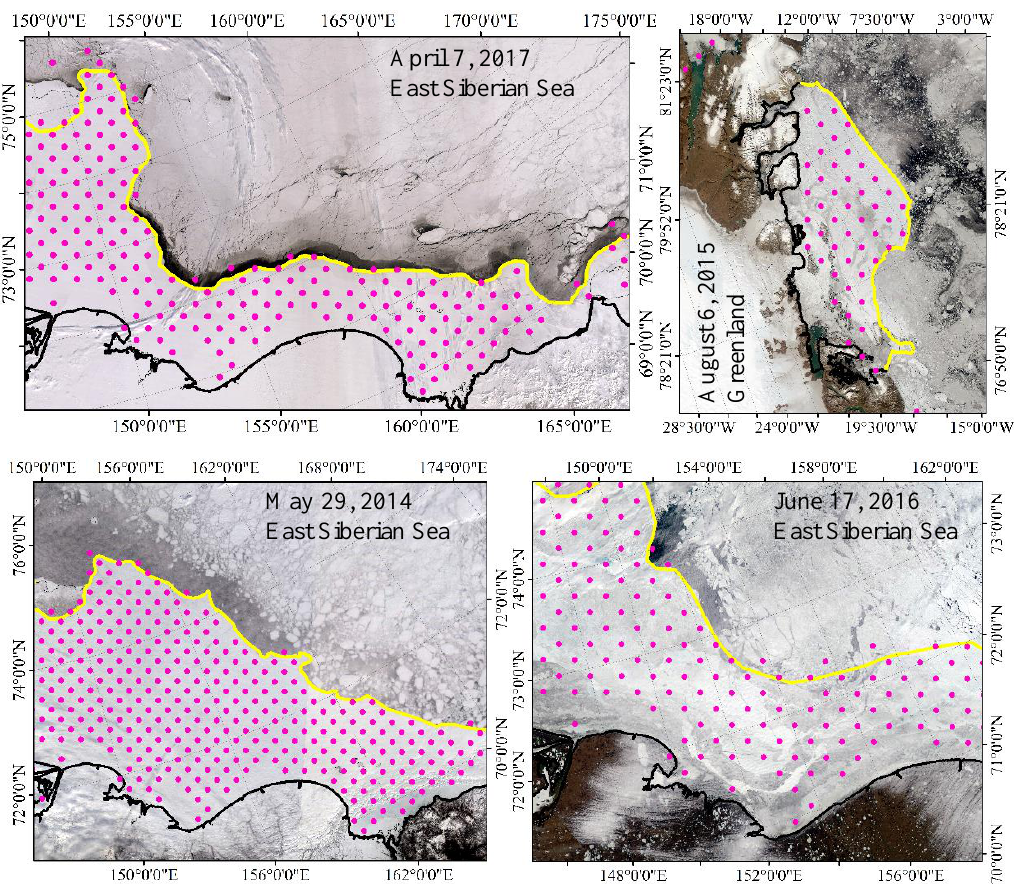
Figure 11. Comparison of the landfast ice extent between the gridded data (pink points) and the MODIS images, which were modified from [30]. The yellow lines represent the boundary of landfast ice detected from the MODIS images.